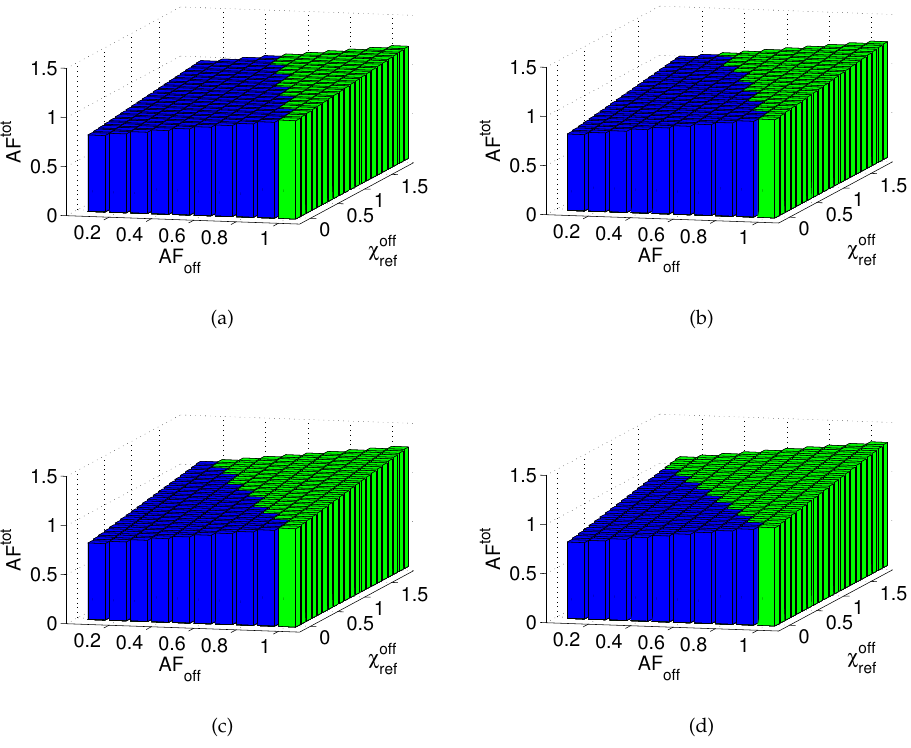
Figure 3. AF tot in the network vs. different values of parameter W (blue bars: AF tot < 1, green bars: AF tot ≥ 1). ( a ) W = 0.05; ( b ) W = 0.1; ( c ) W = 0.15; ( d ) W =